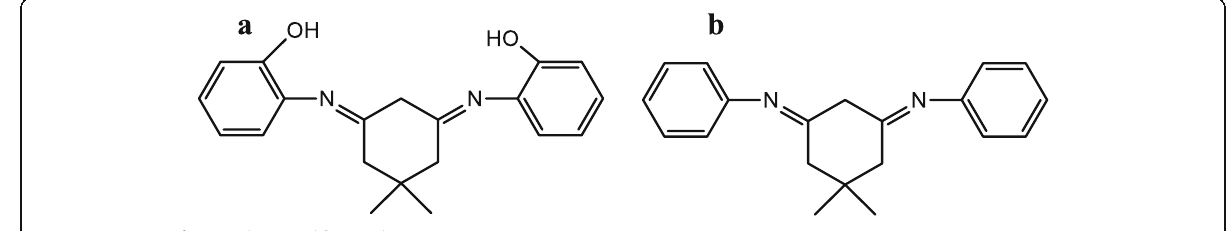
Fig. 1 Structure of a DmChDp and b